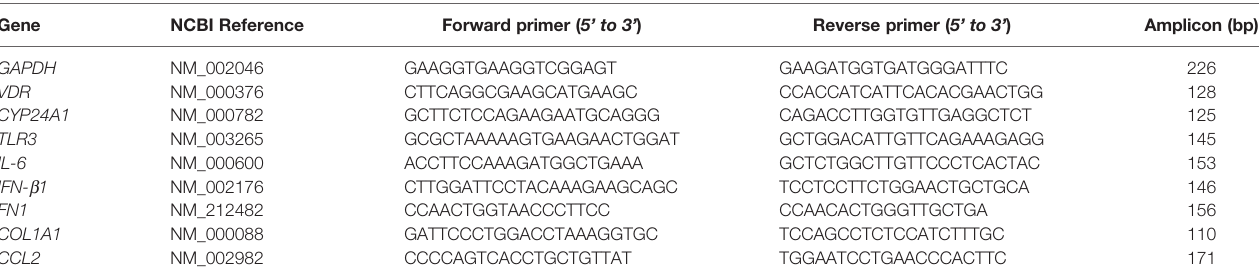
TABLE 2 | Gene speci fi c primer sequences used for